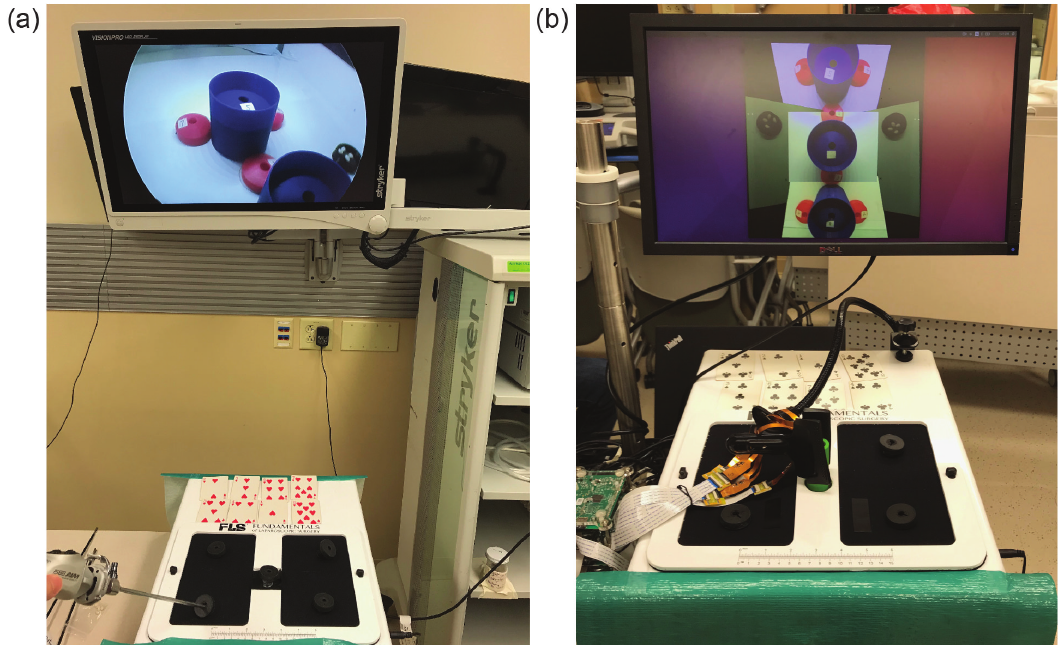
Figure 6. Test Environment: A subject attempted to complete a modified bean drop task in both the traditional laparoscopy visualization environment ( a ), and the micro-camera array visualization environment ( b ). The new environment freed up a hand so that the surgeon can utilize multiple grasping instruments without needing an assistant to hold the